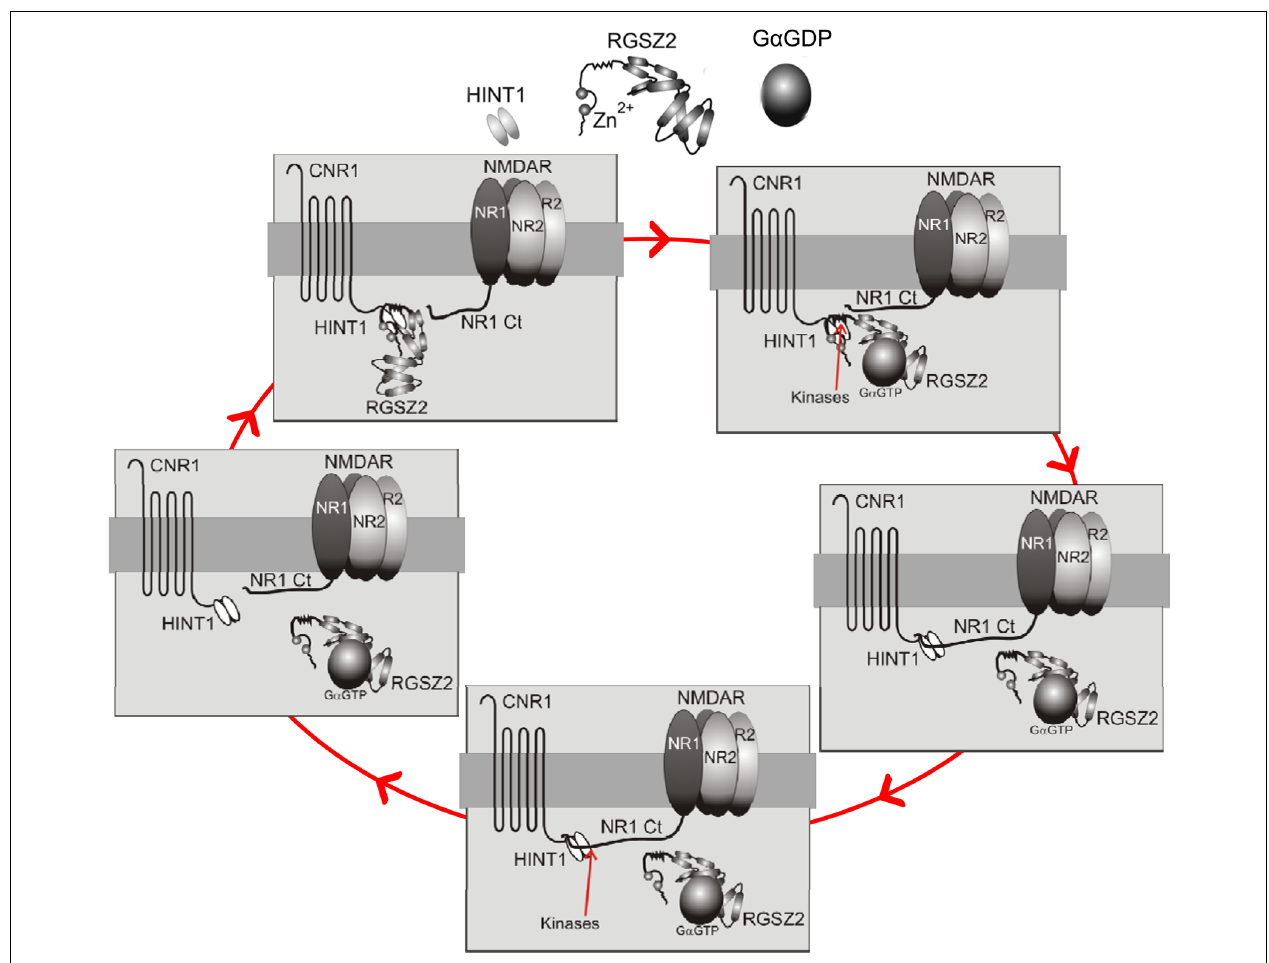
action of other kinases on the NR1 subunit likely reduces its binding to HINT1, or alternatively, the action of phosphatases on HINT1 favors RGSZ2 binding). Note 1: In the absence of cannabinoid activity, there are probably numerous CB1–NMDAR complexes in which the NMDAR is active, but its function is limited (recall that in the absence of CB1s or HINT1 proteins, NMDAR activity increases; Kim etal., 2006; Sánchez-Blázquez etal., 2013b). The aforementioned mechanism may therefore affect the increase in NMDAR activity, which will reach a given threshold (these putative calcium sensors are essential for controlling this).The release of silent NMDARs from the control of activated CB1s is essential to avoid unnecessary glutamate hypofunction. Note 2: In the absence of CB1 activation, a large increase in NMDAR activity, such as that provided by intracerebroventricular (icv) injection of NMDA, forces the PKA-mediated separation of NMDARs from the CB1 and the loss of any potential control (see the transit from the lower panel to the upper left